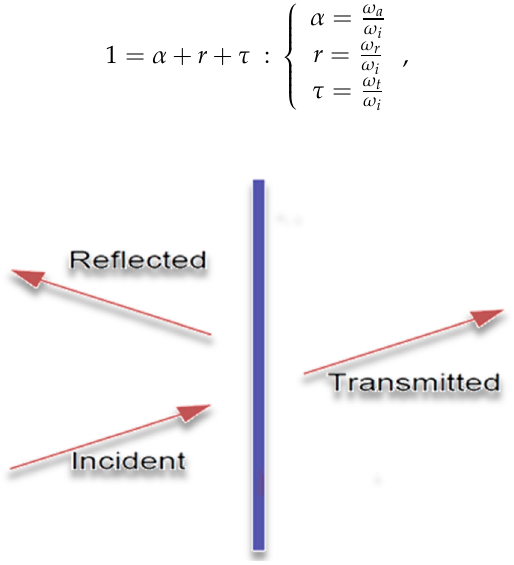
Figure 18. Sound power transmission diagram.